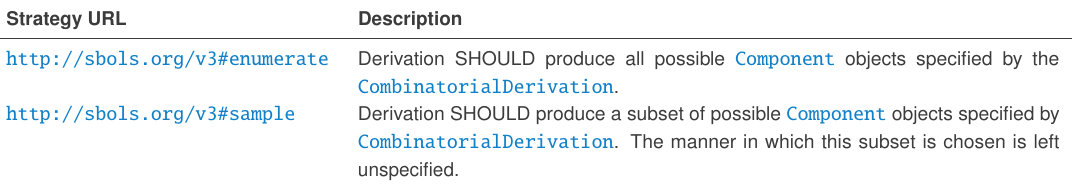
Table 13: REQUIRED URL s for the strategy